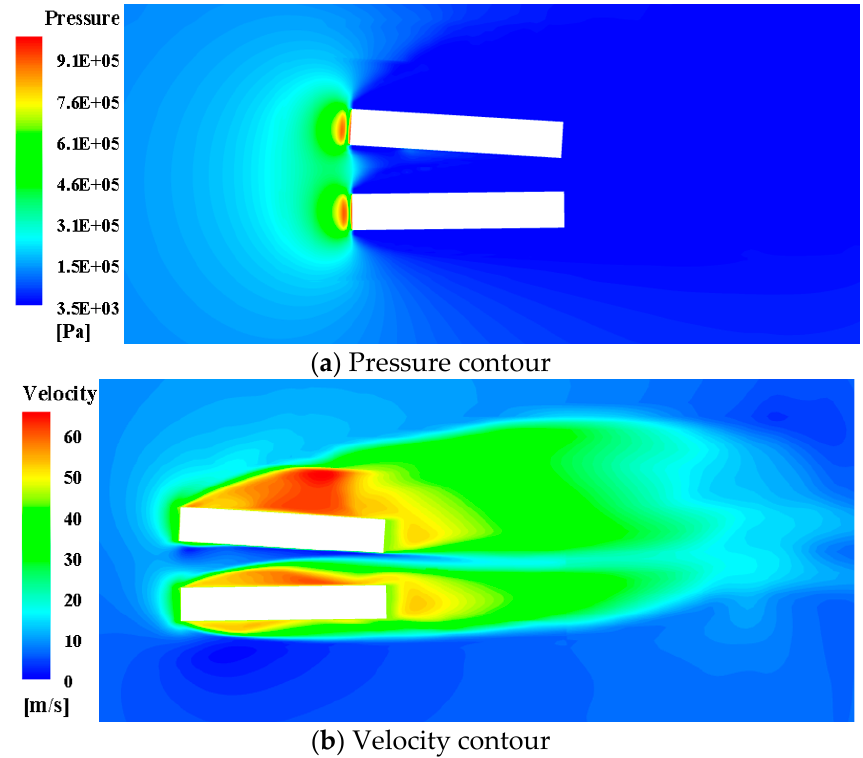
Figure 12. Pressure and velocity contours around the projectiles under the condition of the lateral flow velocity with Vc = 7.5% Vp (t = 2